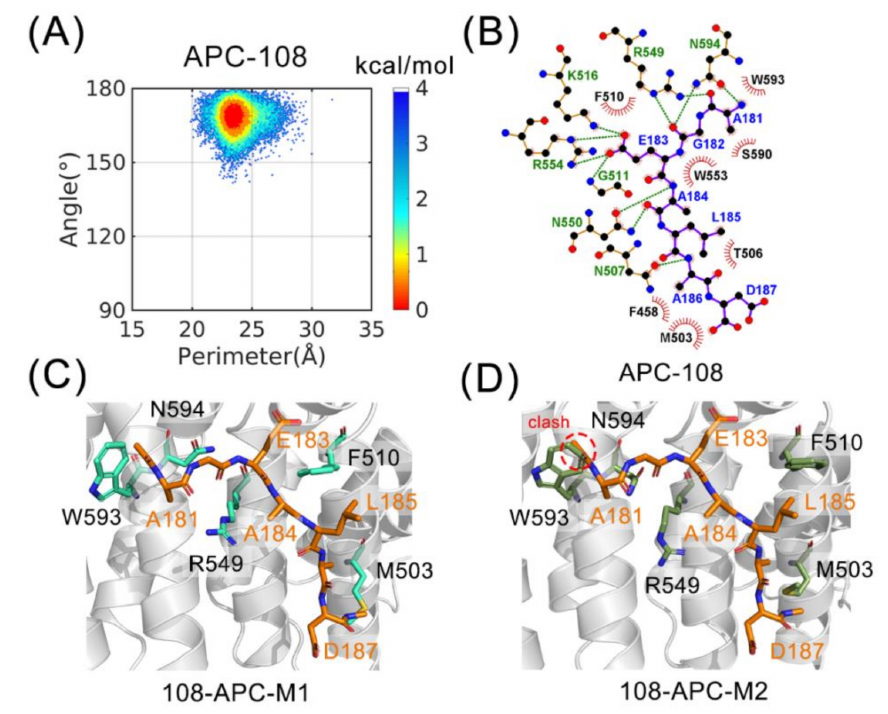
Figure 4. ( A ) Free-energy landscape of APC-108. ( B ) The 2D visualization of the interface of APC-108. ( C ) Structural superimposition of APC-108 to APC-M1. ( D ) Structural superimposition of APC-108 to